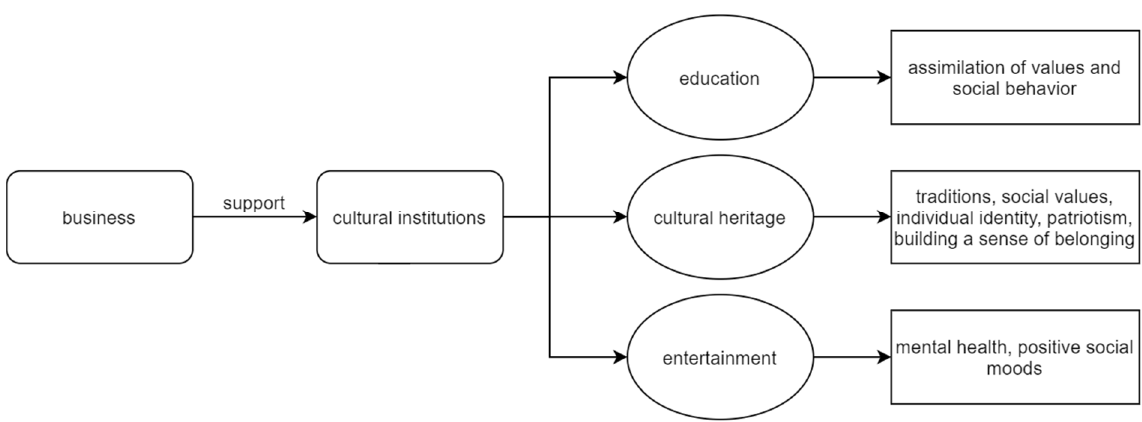
Figure 2. Cultural influence on society. Source: own study.